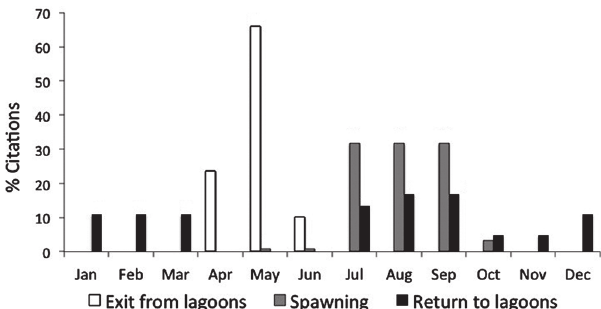
Fig. 3. Percentage of the interviewed fishers (n=45) that cited the month when mullet exiting lagoons/estuaries (‘criadouros’) for migration, spawning and return. Some fishermen cited more than one month for each event, five did not knew about when spawning occurred and seven when mullets returned to the lagoons/estuaries.